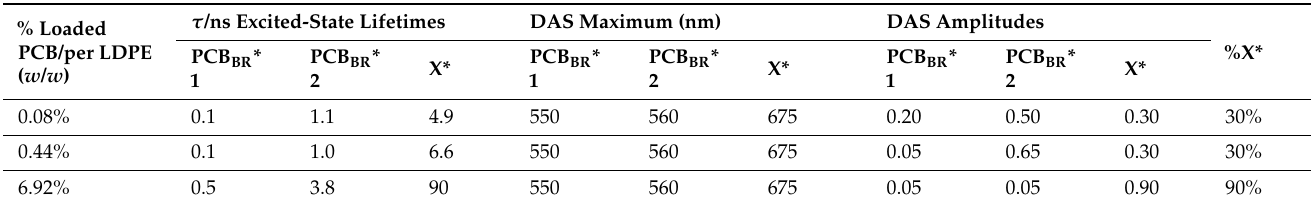
Figure 4. DAS of solid PCB@LDPE films at 298 K (excitation at 510 nm). The total concentrations of PCB and global excited-state lifetimes are indicated directly in the graph ( A – D ). DAS spectra in methanol are added for comparison. Table 3. Excited-state lifetime values, DAS maxima, and amplitudes extracted from DAS global analysis (excitation at 510 nm).